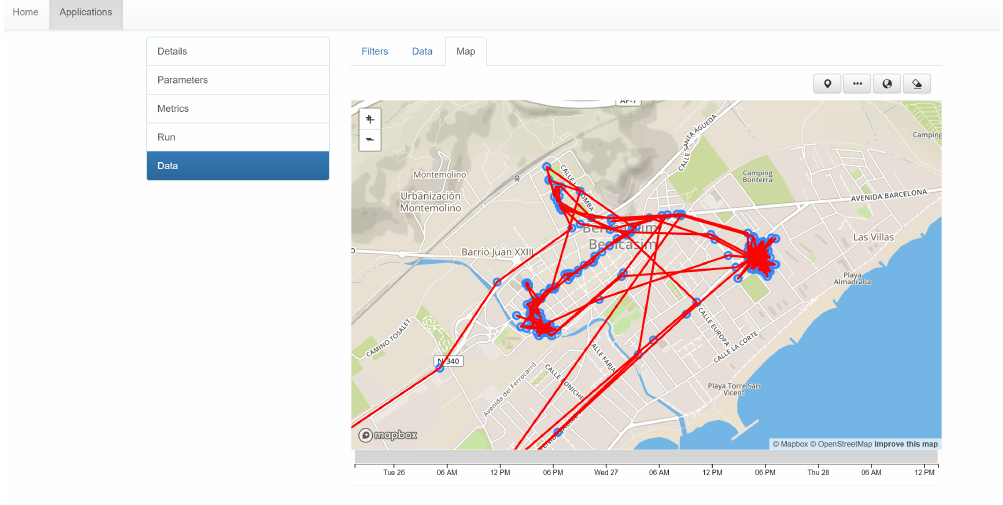
Figure 10. Map-based visualisation of collected trajectory data stored in the analytics